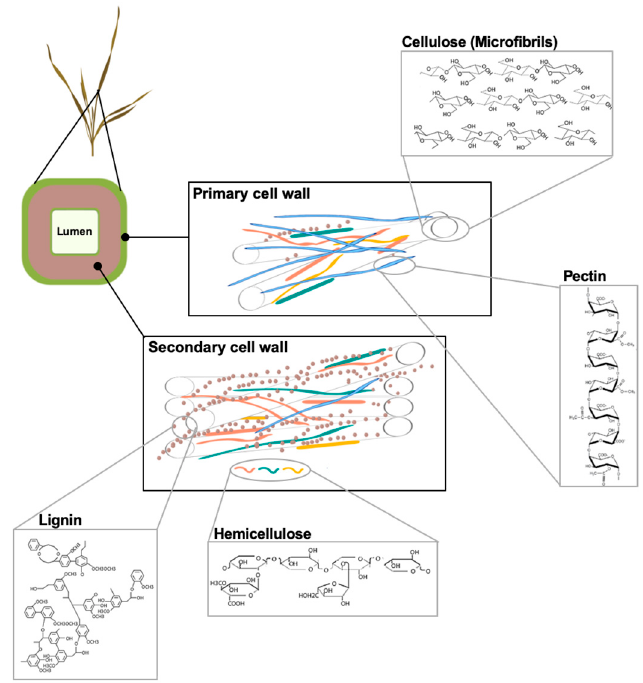
Figure 1. Schematic representation of plant primary and secondary cell walls. In the primary cell wall, cellulose chains are organized in fibrillar structures (white) that engage hemicellulose (orange, yellow, and green) through hydrogen bonds. This assembly is surrounded by a complex matrix of pectin (turquoise). In the secondary cell wall, pectin decreases in favor of a higher content of lignin (brownish dots) that adsorbs to cellulose fibers and confers recalcitrance to enzymatic hydrolysis. Structures of arabinoxylan and substituted homogalacturonan are reported as representative classes of hemicellulose and pectin, respectively.